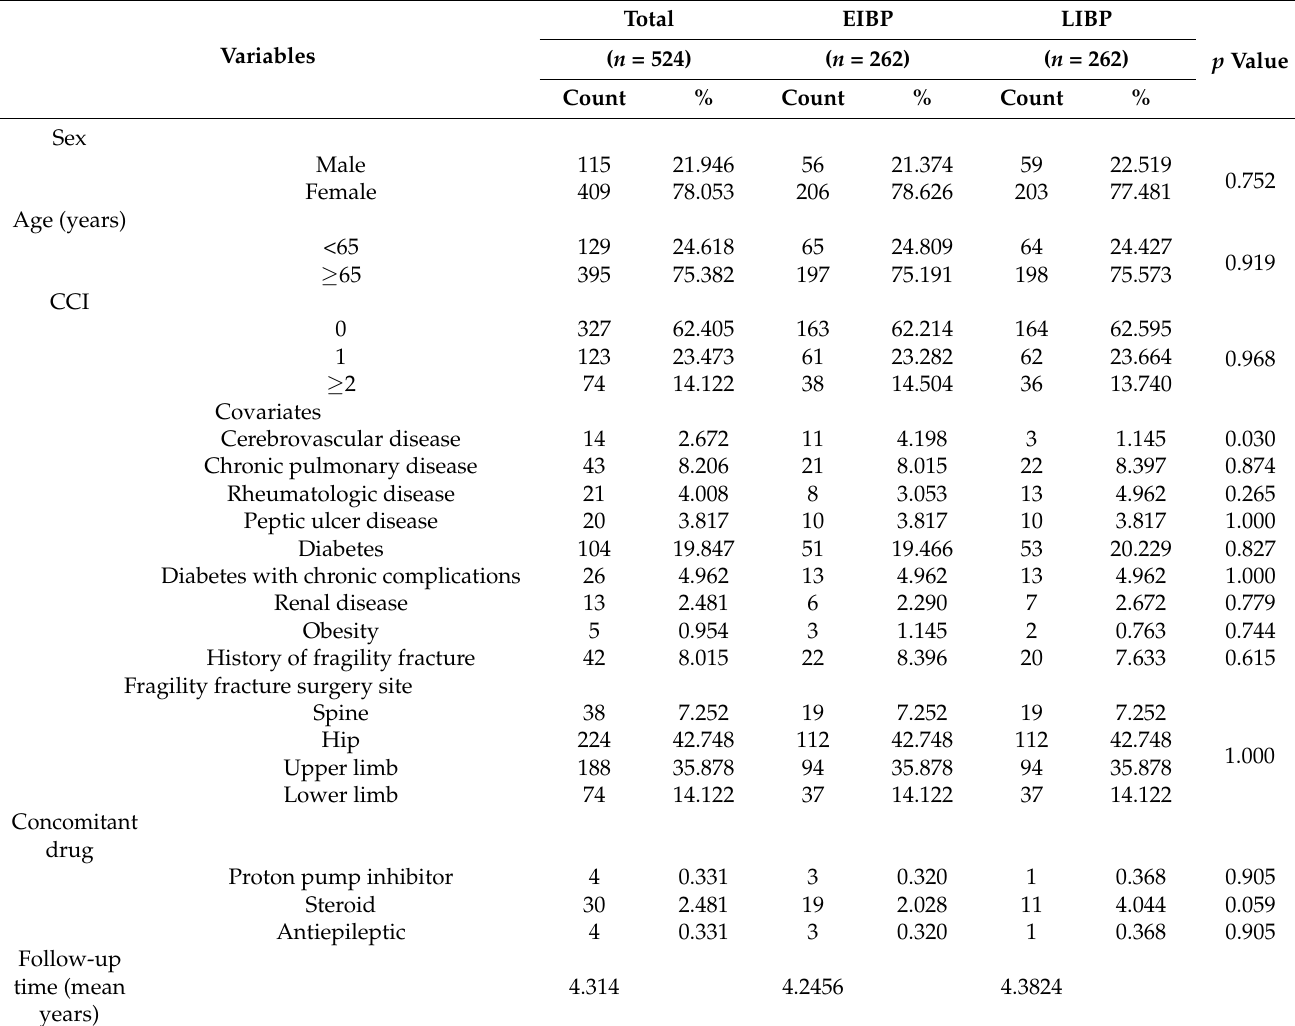
Table 1. Clinicodemographic characteristics of the study